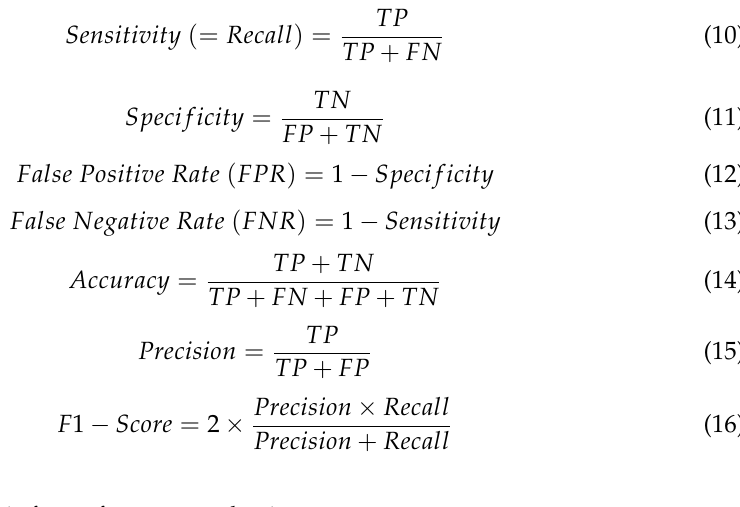
Table 2. Confusion matrix for performance evaluation.